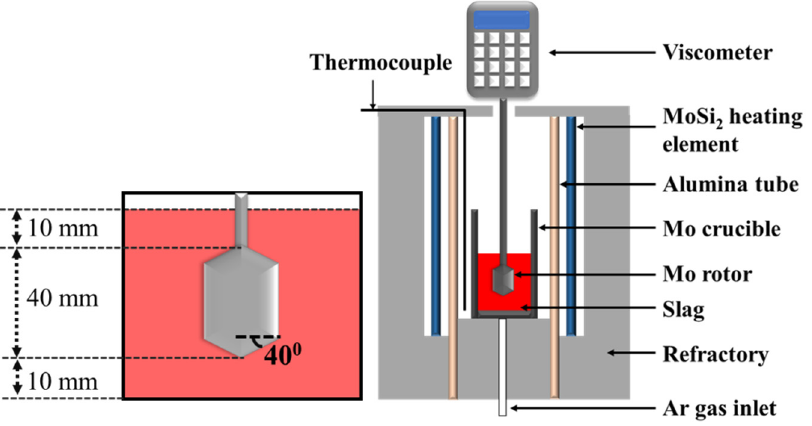
Figure 1. Schematic representation of the setup used for analyzing the viscosity of samples.